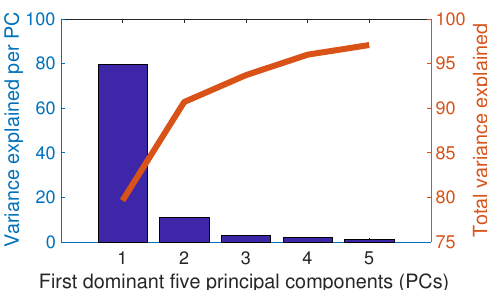
Figure 4. Variance explained by the first five principal components (PCs). The solid line represents the total variance